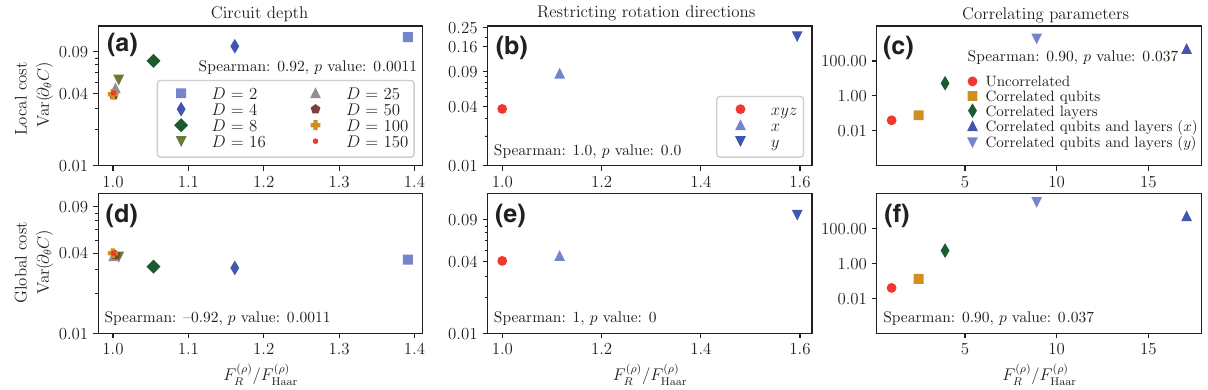
FIG. 7. Correlations between cost partial derivatives and the state -dependent frame potential. The variance in the partial derivative (cid:11) n σ z σ z of a global cost with H = (top) and the 2-local cost with H = σ z (bottom) as a function of the expressibility measure i i = 1 1 2 F (ρ) / F (ρ) { in both cases, ρ = | ψ (cid:7)(cid:8) ψ | ⊗ n where | ψ (cid:7) = exp[ − i (π/ 8 )σ | 0 (cid:7)} . In the left panel, we vary the circuit depth D of a 0 0 0 Y ] R Haar hardware-efficient ansatz. In the right (middle) panel, we consider the effect of correlating parameters (restricting the directions of rotation) of a hardware-efficient ansatz with D = 100, with the choices of correlations (rotations) indicated in the figure legend. In all , and the variance and frame potentials are estimated using an ensemble of 5000 cases, n = 4, the derivative is taken with respect to θ 1 D